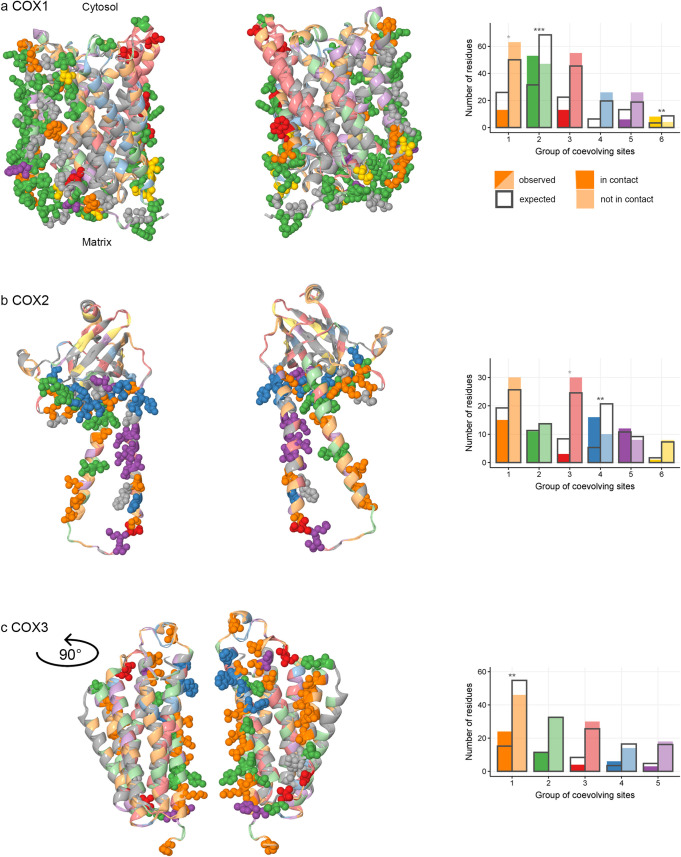
Groups of concordantly evolving sites and interactions between subunits of COX.For each mitochondrial-encoded COX protein: COX1 (a), COX2 (b) and COX3 (c), structures of two identical subunits within the crystallized homodimer are shown (PDBID: 1occ). The groups of coevolving sites are color-coded. (a,b,c on the left) protein structure of COX. Residues at sites involved in interactions with other COX proteins are shown as spheres; residues at sites on protein surfaces not involved in interprotein interactions, as ribbons; the remaining sites (internal sites or sites that were excluded from analysis) were colored in gray. (a,b,c on the right) the numbers of sites which are in contact and numbers of sites which are not in contact with other COX proteins in the protein structure, compared to the expected values. Significant differences are marked with asterisks (*, p<0.025; **, p<0.005; ***, p<0.0005). For COX1 (a), interactions with nuclearly encoded COX proteins are considered; for COX2 and COX3 (b, c), interactions with other mitochondrial-encoded COX proteins are considered.